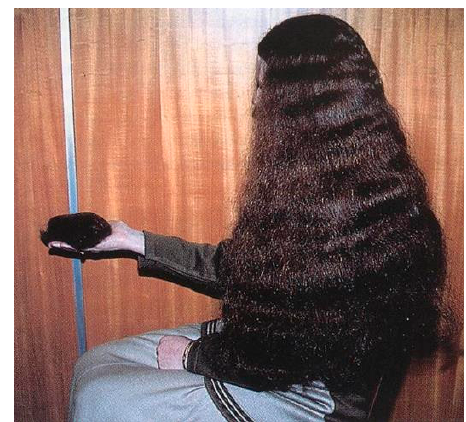
Figure 3. Primary Chronic telogen effluvium. This woman presented with increased hair shedding, reduction in the thickness of her pony tail by 50% and mild bitemporal recession but without any widening of her midline part line. Scalp biopsy was normal with no increase in the ratio of vellus:terminal hairs.